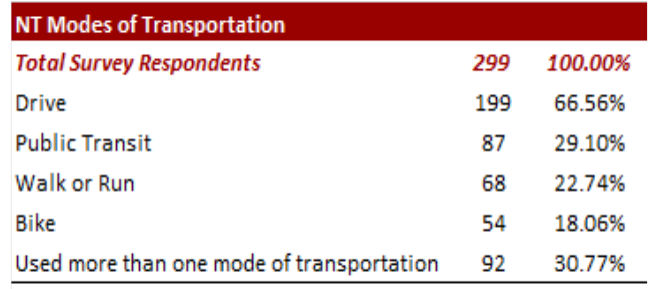
Figure 4. Modes of transportation to access the JRPT. source: created by authors for this paper.